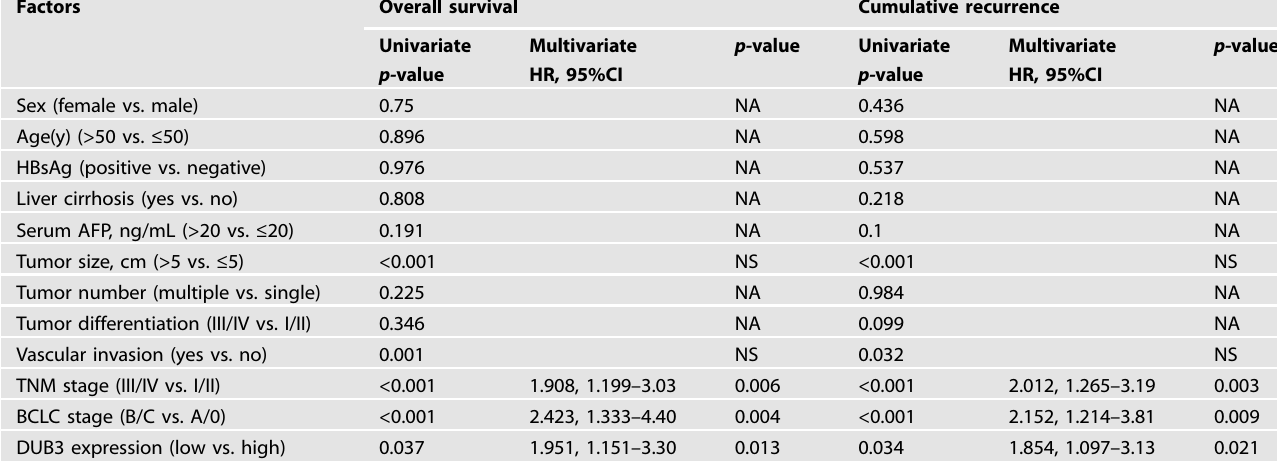
Table 1. Univariate and multivariate analyses of factors associated with survival and recurrence in 150 HCC. Factors